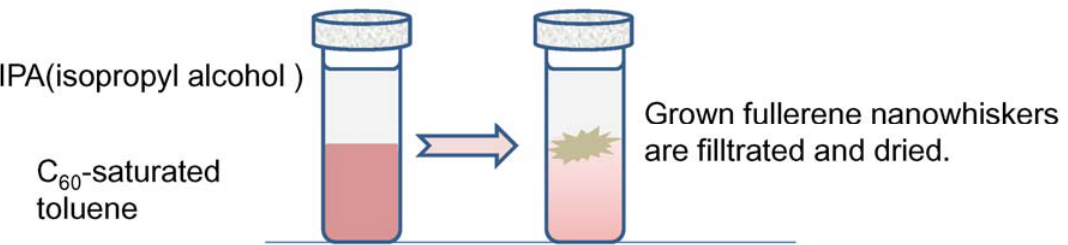
Figure 7. A schematic diagram of the liquid-liquid interfacial method (LLIP